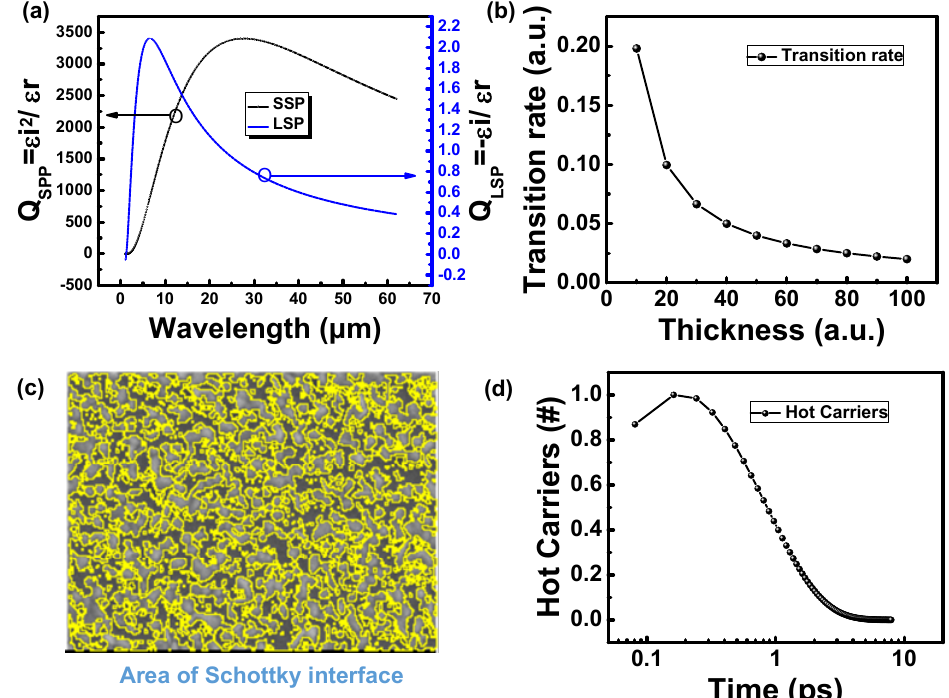
Figure 9. ( a ) Relationship between plasmon resonance quality factor and wavelength at Cr surface; ( b ) relationship between hot carrier transition rate and thickness; ( c ) schematic diagram of effective surface area; ( d ) decay of hot carrier number with time.